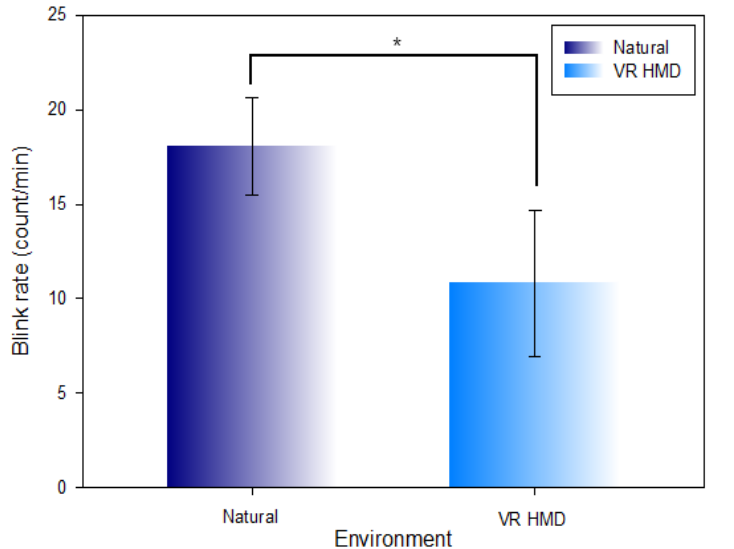
Figure 7. Comparison of the blink rate in the natural environment and VR HMD environment (*: p